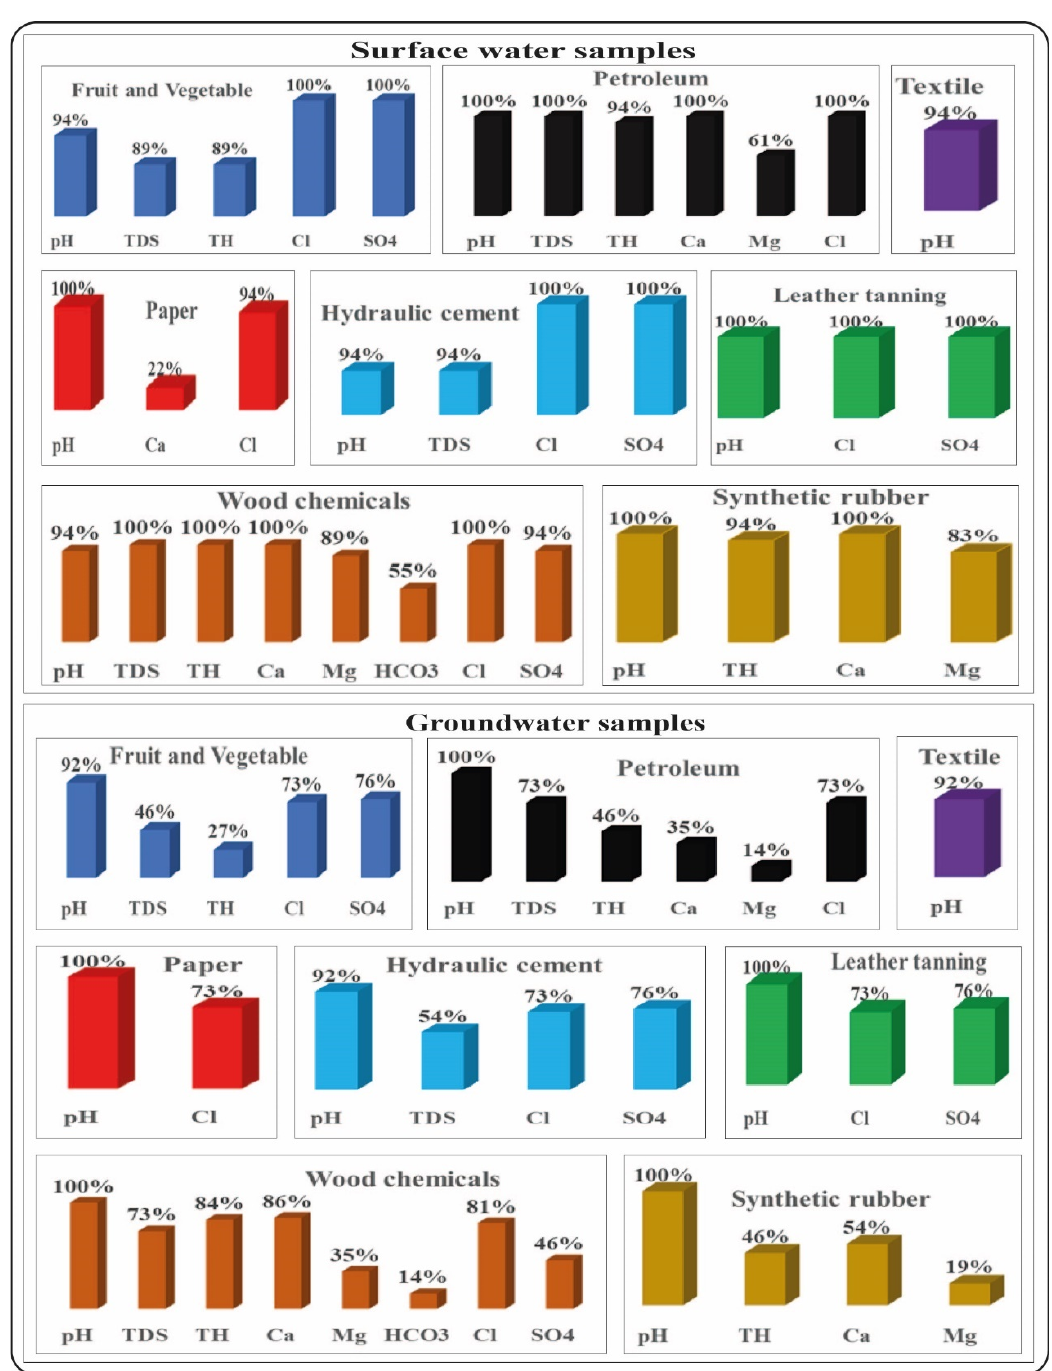
Figure 8. Percentages of the water parameters under investigation that are appropriate for some